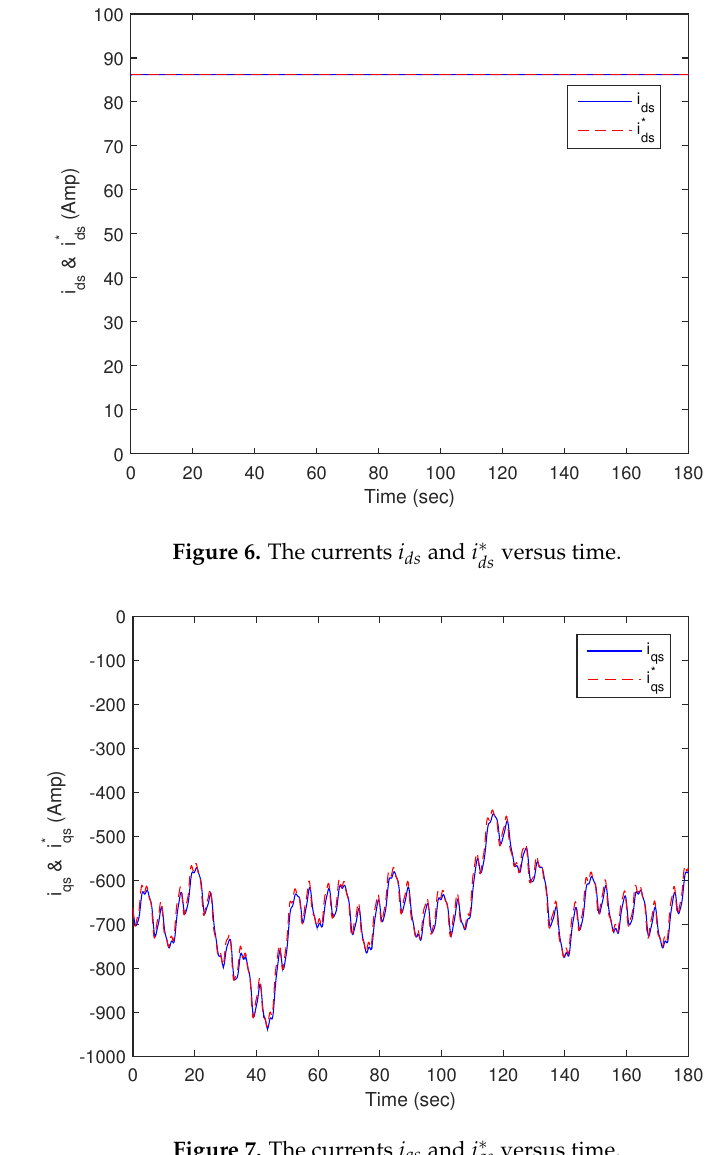
Figure 7. The currents i qs and i ∗ qs versus